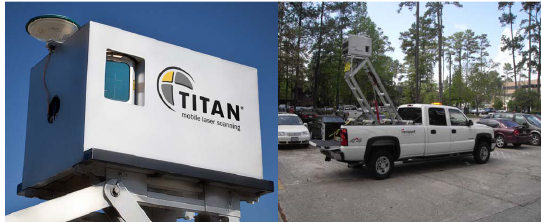
Figure 1. TITAN mobile laser scanning system. Left: Close view. Right: Mounted on a truck. www.ambercore.com